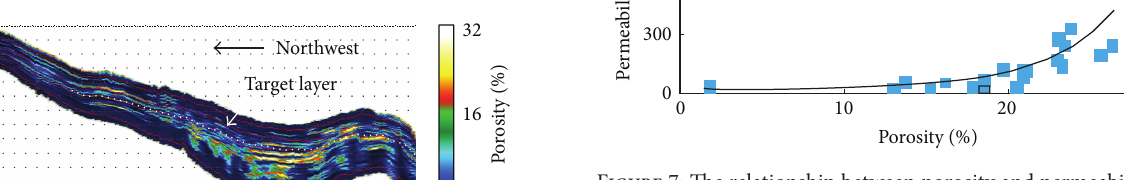
Figure 7: The relationship between porosity and permeability 𝐾 = 0.707 ∗ 𝑒(0.2412 ∗ Φ) . resistivity among mudstone and sandstone; this information helps us to use resistivity log data to divide the